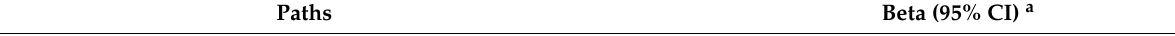
Table 5. Standardized regression coefficients (95% confidence intervals (CI) a ) from linear model of the association between depressive symptoms and heavy episodic drinking (HED) in adolescents who had engaged in HED ≤ 1 time at wave 1 ( n =